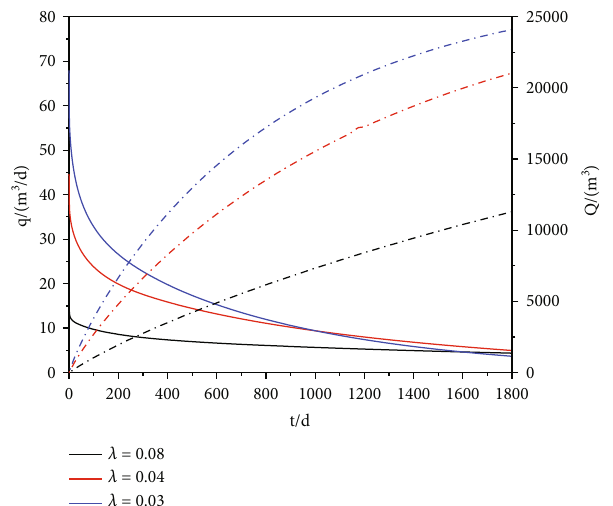
Figure 8: Daily production and accumulative production under di ff erent pore radius ratios (set 1, set 2, and set